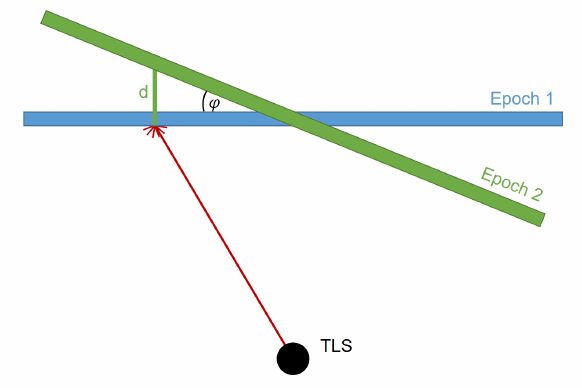
Figure 3. Change detection and quantification schema. The distance d is calculated orthogonal to the board position at Epoch